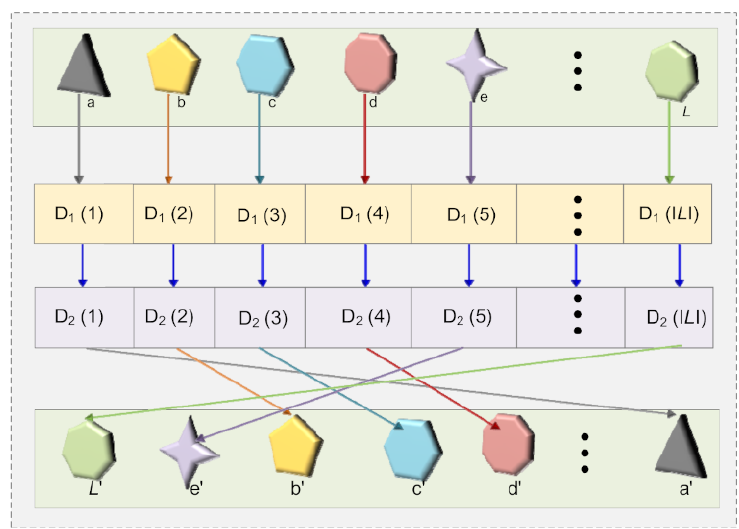
Figure 5. Double random position